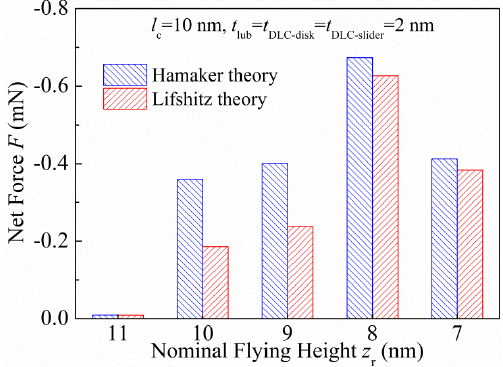
Figure 5. Comparisons of the net force predicted by the Lifshitz theory and the Hamaker theory.